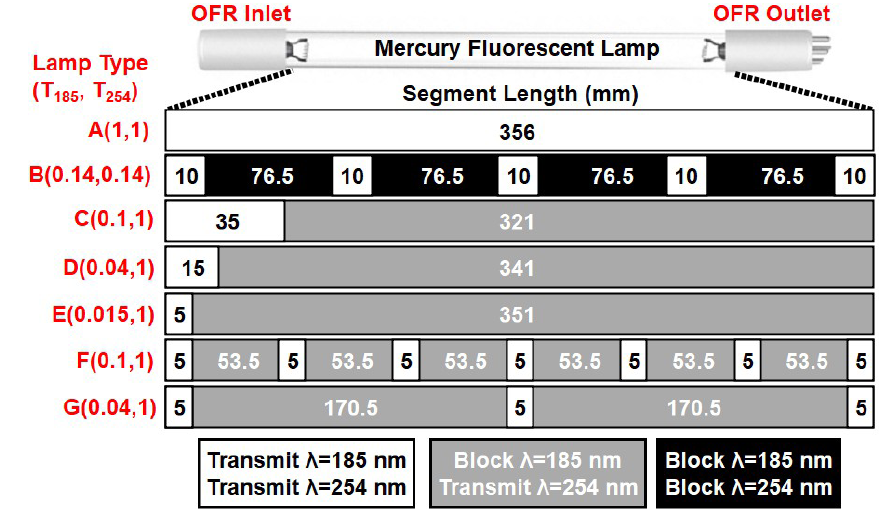
Figure 1. Low-pressure Hg fluorescent lamp types used in this study. Each lamp type contains 356mm of quartz material that either transmits both λ = 185 and 254nm radiation (white, T 185 = 1), blocks λ = 185nm and transmits λ = 254nm radiation (grey, T 185 = 0), or blocks both λ = 185 and 254nm radiation (black, T 185 = 0).